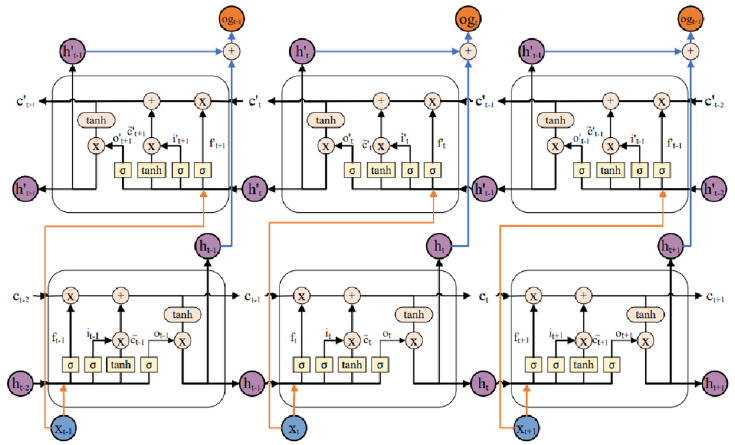
Figure 3. Basic structure of three-stage Bi-LSTM network.